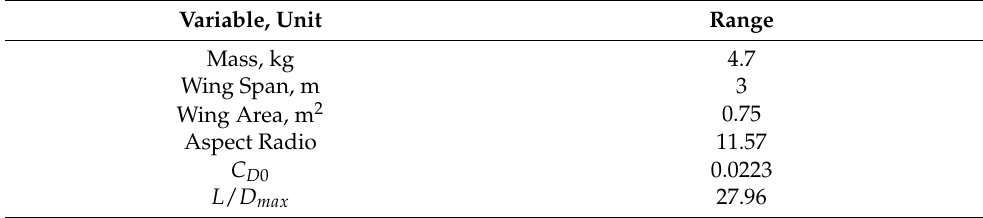
Table 1. The Fox’s